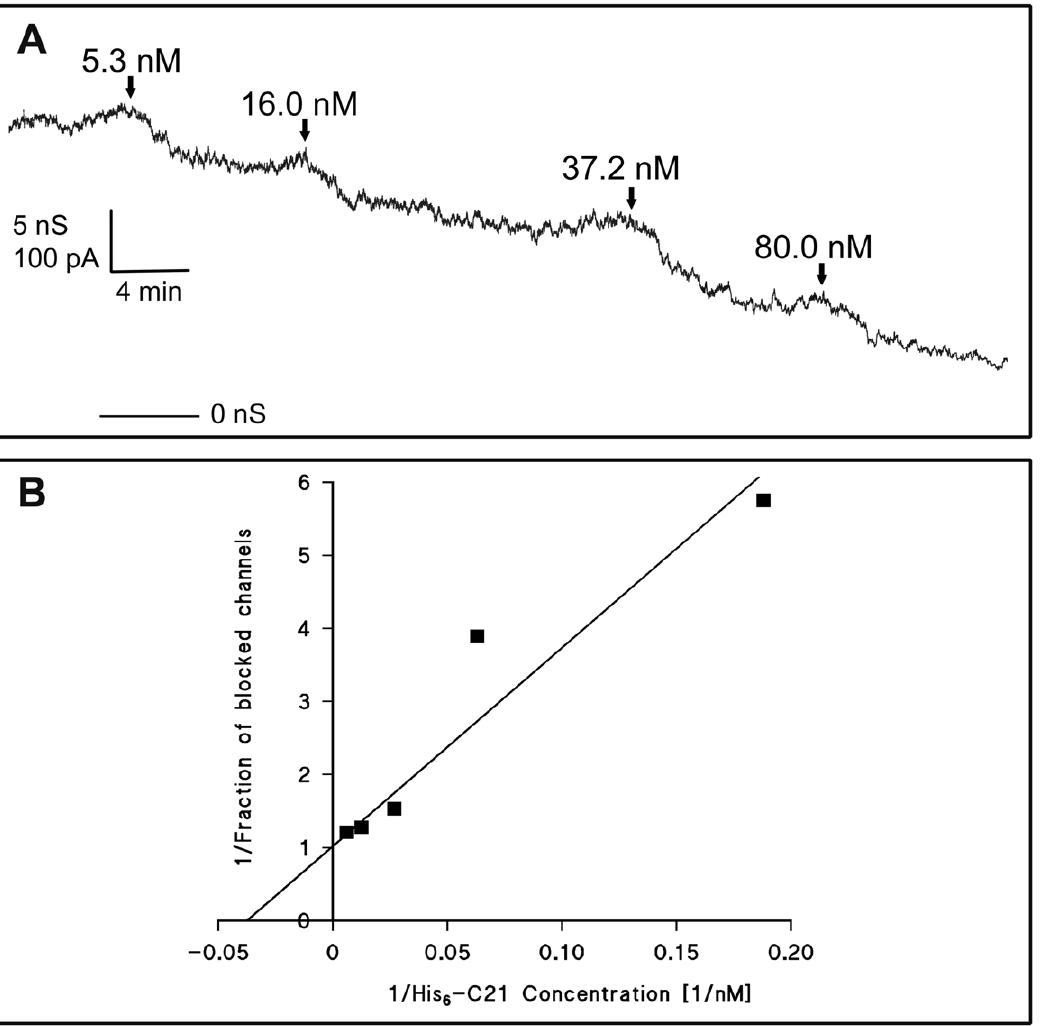
Figure 1. Interaction of C2I with PA 63 channels. A: Titration of PA 63 induced membrane conductance with His 6 -C2I. The membrane was painted from 1% (w/v) diphytanoyl phosphatidylcholine dissolved in n-decane. It contained about 300 PA 63 -channels. His 6 -C2I was added at the concentrations shown at the top of the panel to the cis -side of the membrane. Finally, about 83% of the PA 63 -channels were blocked. The aqueous phase contained 1 ng/ml activated PA 63 (added only to the cis -side of the membrane), 150 mM KCl, 10 mM MES-KOH pH 6. The temperature was 20 u C and the applied voltage was 20 mV. B: Lineweaver-Burk (double reciprocal) plot of the inhibition of the PA 63 -induced membrane conductance by His 6 -C2I using equation (2). The fit was obtained by linear regression of the data points taken from Figure 1A and corresponds to a stability constant K for His 6 -C2I binding to PA 63 of (3.93 6 0.39) 6 10 7 M 2 1 (r=0.955; half saturation constant K s =25